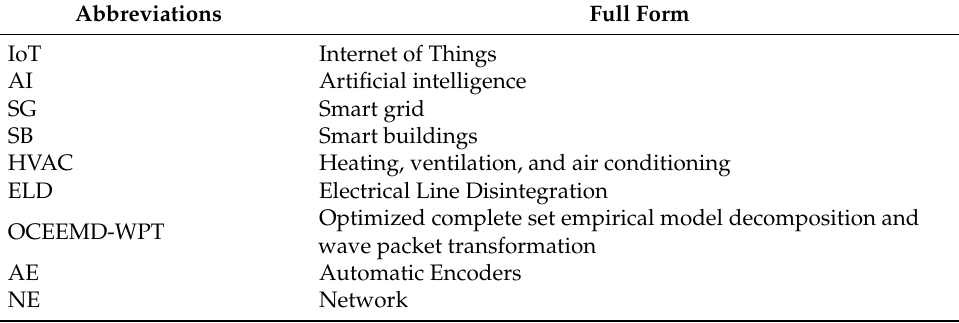
Table 1. List of